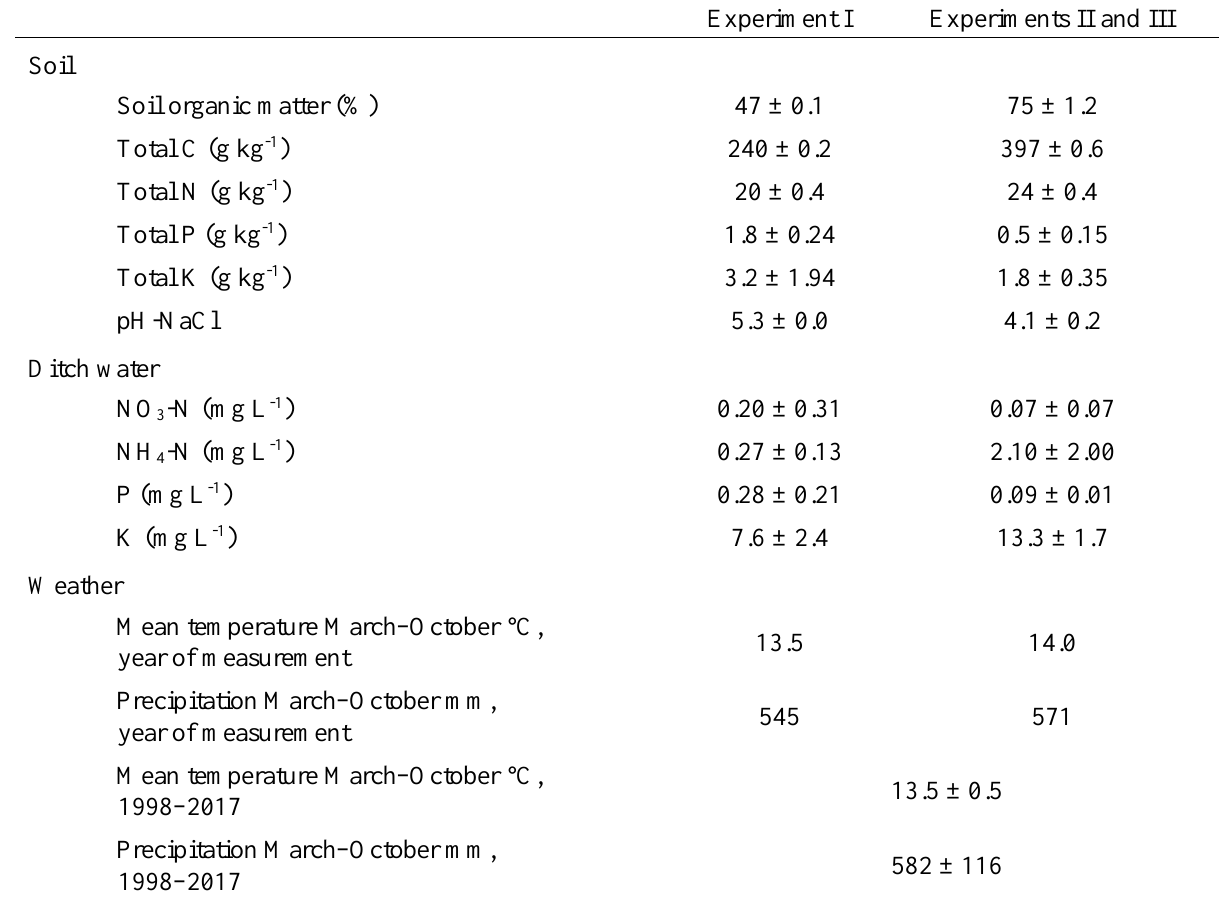
Table 1. Soil, ditch water and weather averages (± standard deviations) determined at the sites used for Experiments I and II +